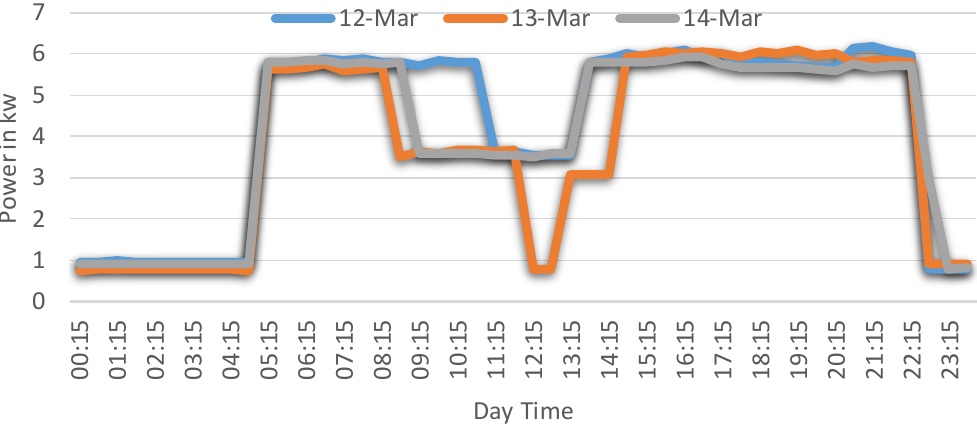
Figure 7. IoT data measured and represented. Example from the light consumption of a classroom.